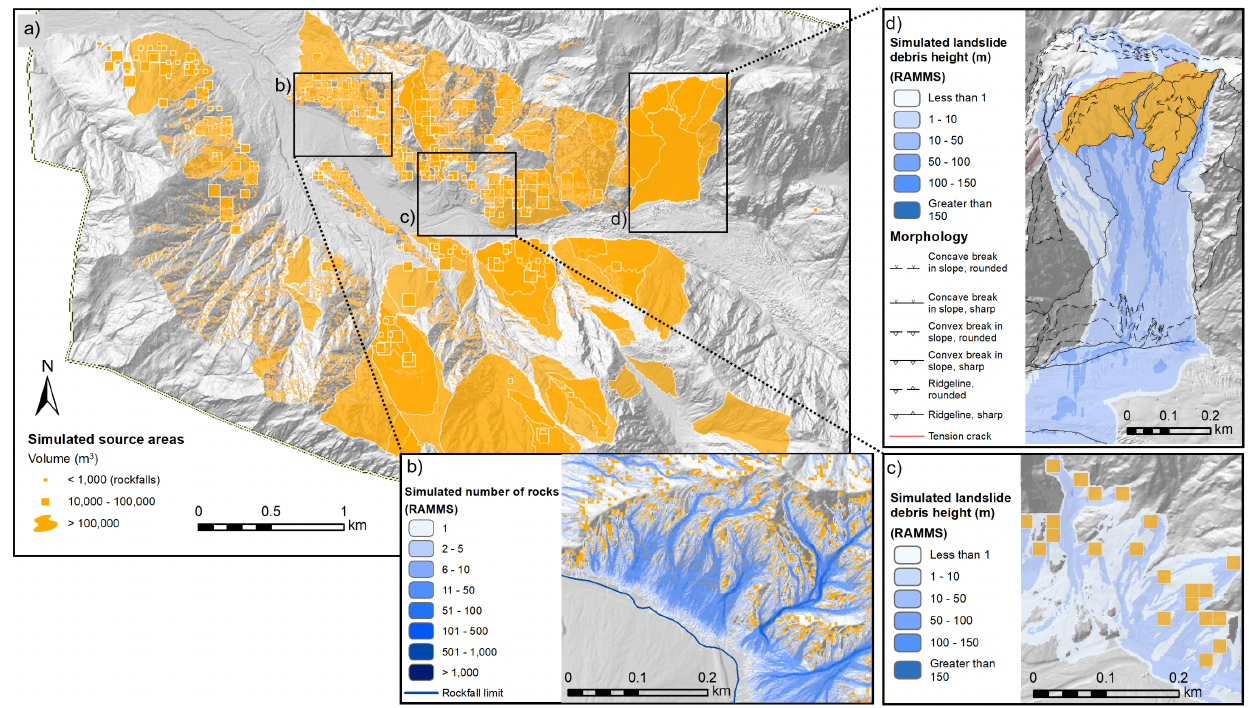
Figure 5. (a) Simulated source areas in the Fox Glacier valley for all volume classes. (b) Numerical rockfall simulations, using RAMMS, from pixel source areas. (c) Numerical debris avalanche and debris flow simulations, using RAMMS, from pixel source areas for volume classes 10 4 to 10 5 m 3 . (d) Numerical debris avalanche simulations, using RAMMS, for geomorphically defined source areas for volume classes ≥ 5 × 10 5 m 3 .